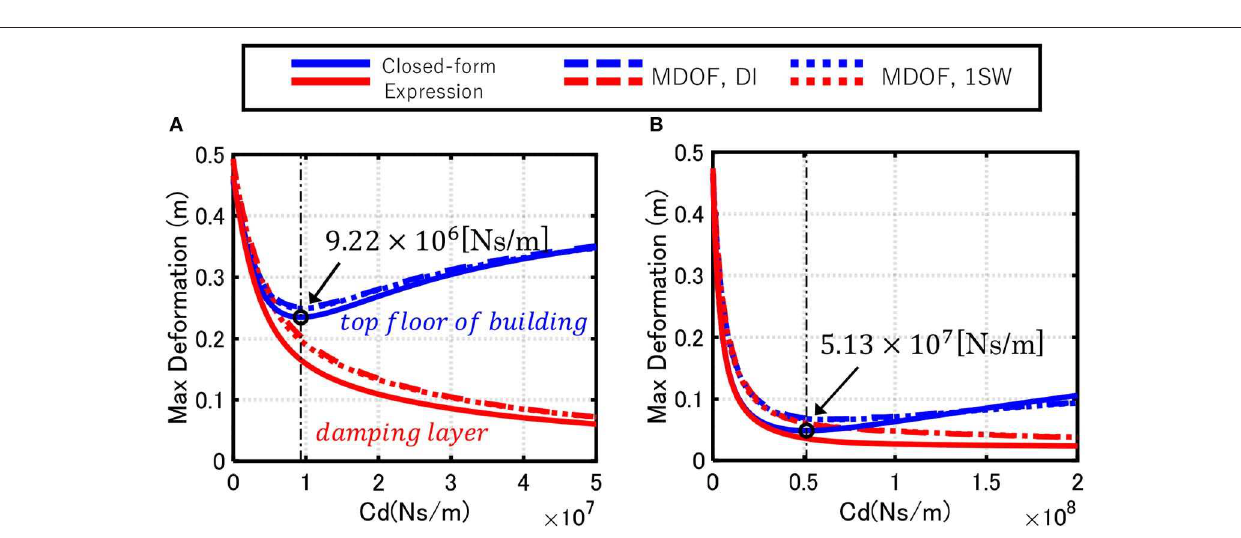
FIGURE 8 | Comparison of maximum displacements among closed-form expression for SDOF model under multi impulse, time-history response analysis for MDOF model under multi impulse and time-history response analysis for MDOF model under 10-cycle sine wave. (A) Original Model and (B) Stiffer Model.